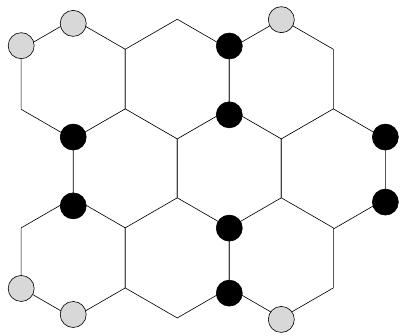
Figure 5. Total dominating set on H 3,3 . Black vertices belong to S 1 ∪ S 2 ∪ · · · ∪ S 4 . Gray vertices must be added to the totally dominating set to dominate L 1 , L 4 and the last column n =